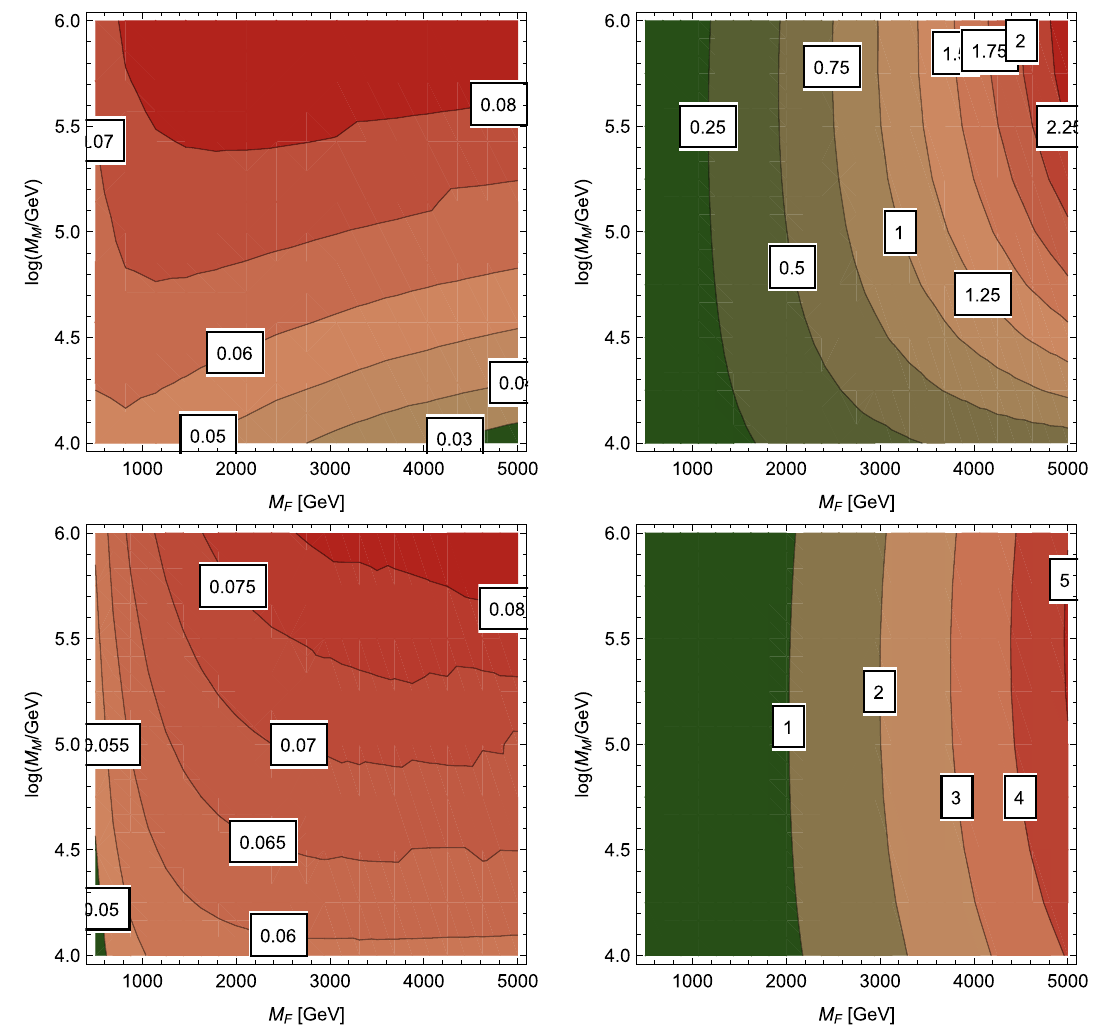
Fig. 4 The change in the Higgs mass in GeV due to the two-loop corrections involving the new Yukawa-like interactions ˜ g ( 1 , 2 )( u , d ) . On the top, we used tan β = 1 at M M and on the bottom tan β = 10. The left plots are with the consistent tadpole solutions, the right ones